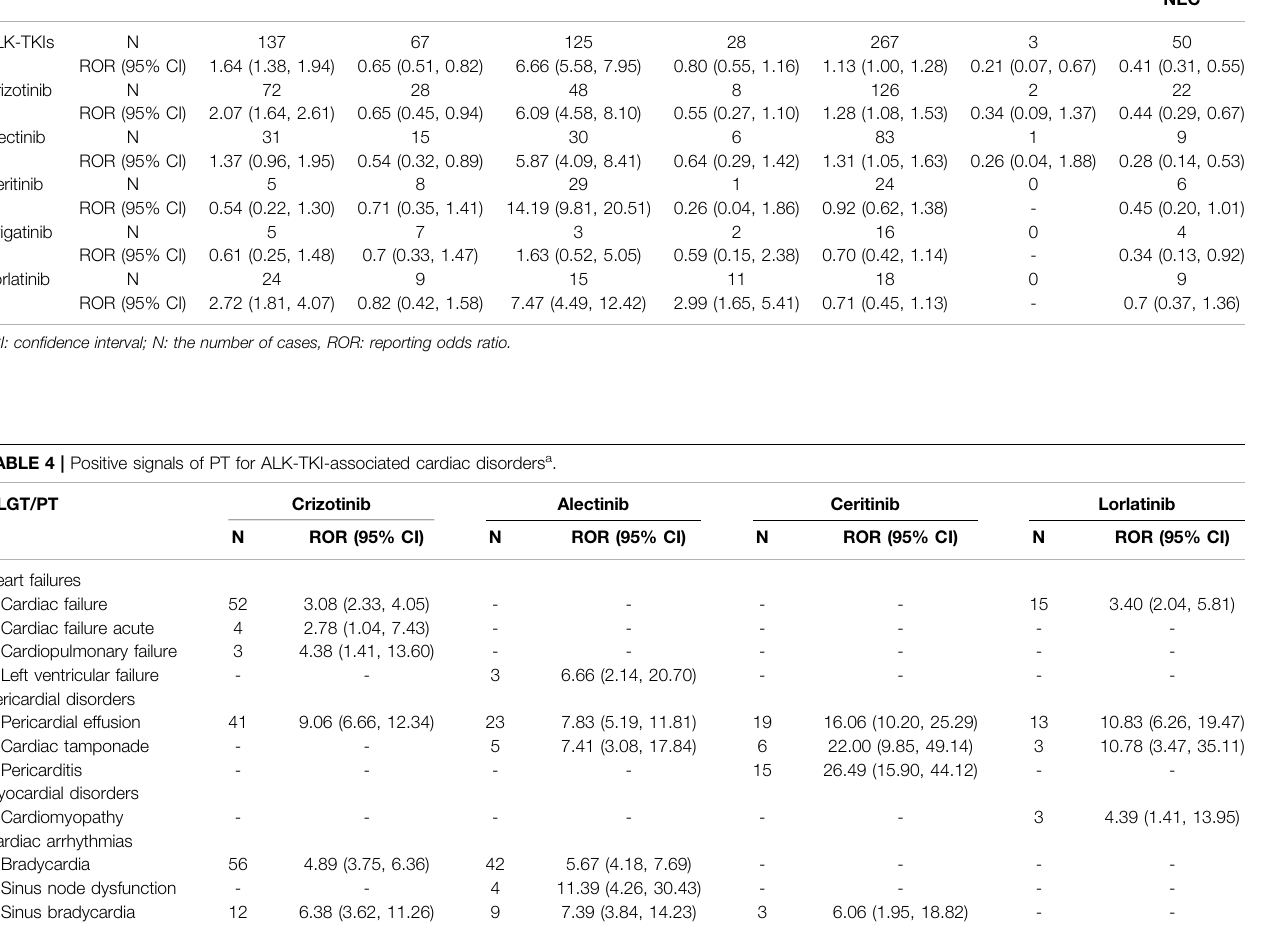
Cardiac Cardiac valve disorders, disorders signs, and symptoms NEC